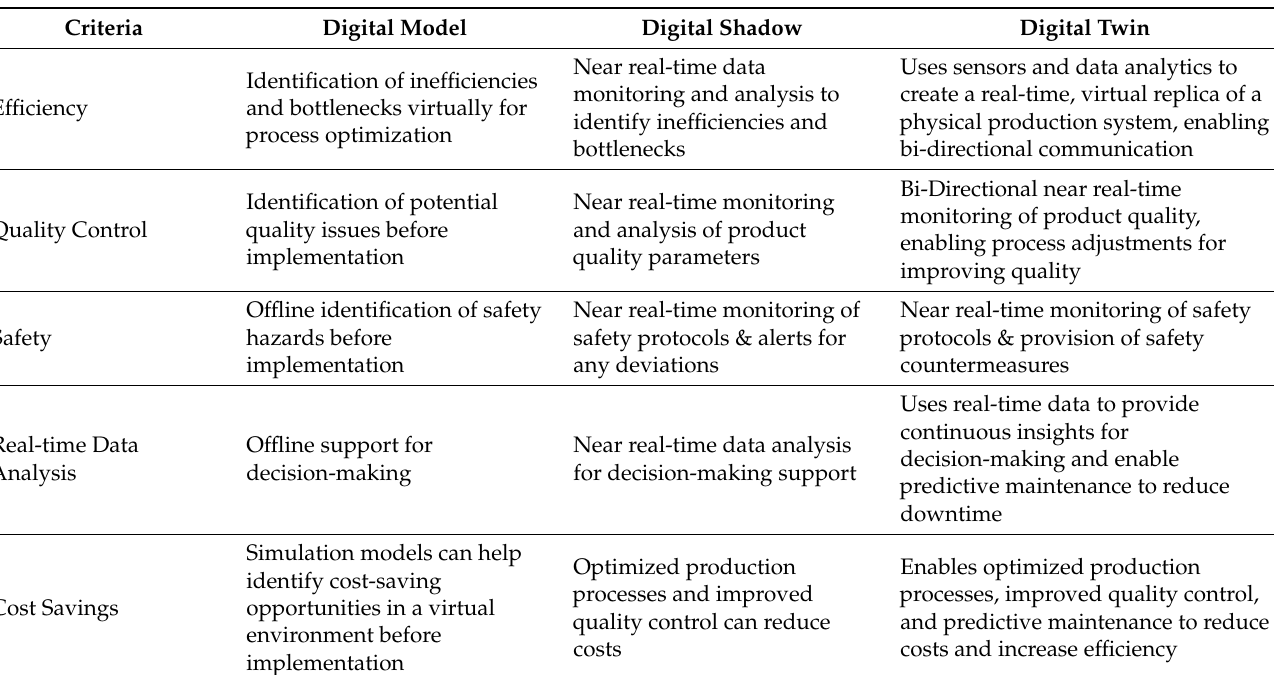
Table 2. Comparative analysis of Digital Model, Digital Shadow, and Digital Twin.